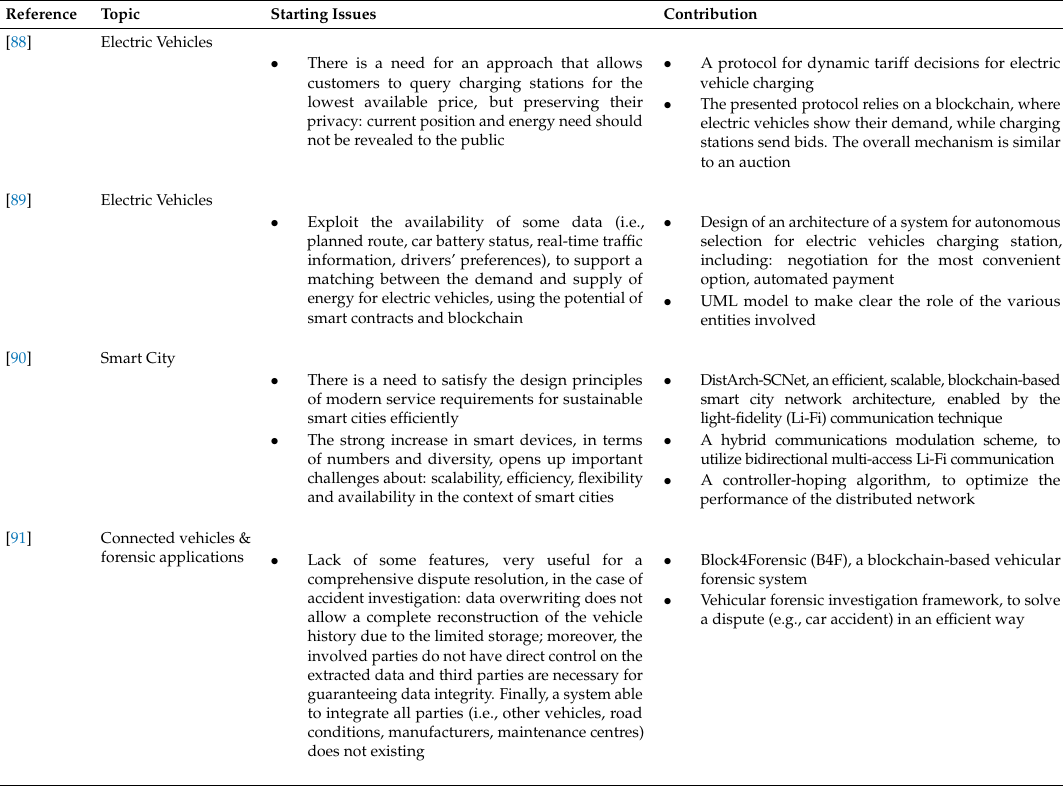
Table 10. Analysis of the most relevant documents belonging to C 2 (part